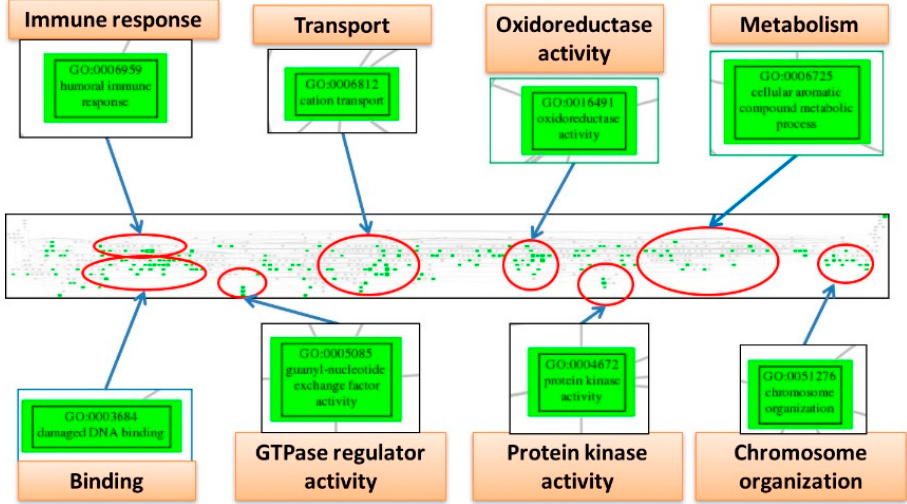
Figure 5. The GO tree of deregulated functions from exploratory factor analysis for clear cell carcinoma. This figure displays the screenshot of the full GO tree for ovarian clear cell carcinoma (CCC) (middle panel). After mapping to the GO tree, the similar or related GO terms are clustered together. Each cluster is circled (red), and the important deregulated GO terms (green boxes) in the cluster were magnified to view the details. Each cluster is labeled by the common parental GO term (orange rectangle).